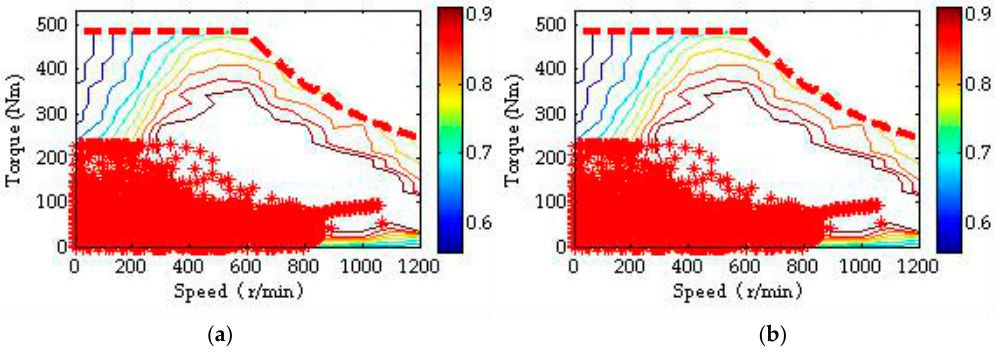
Figure 11. Operating region for ( a ) the front-axle motors and ( b ) the rear-axle motors under the case of BSBC and hybrid driving cycle.